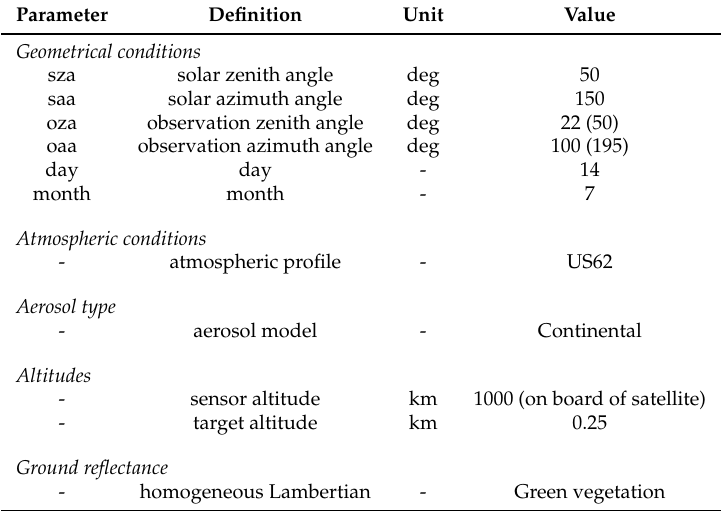
Table A2. Input parameters of 6S atmospheric model that were fixed during the global sensitivity analysis. Angles in brackets are related to the oblique view. Varied 6S parameters are listed in Table 1.